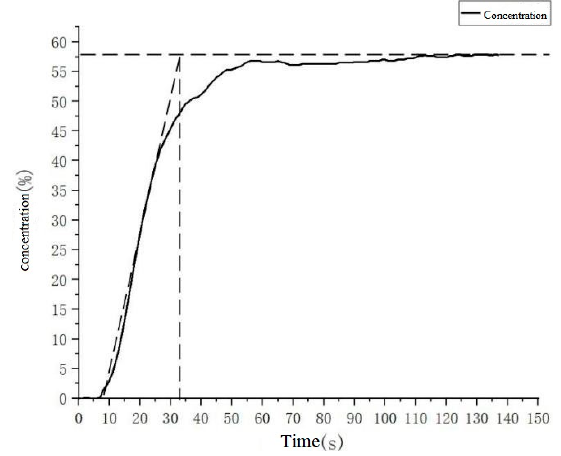
Figure 15. First-order pure lag system curve of the gas distribution system.